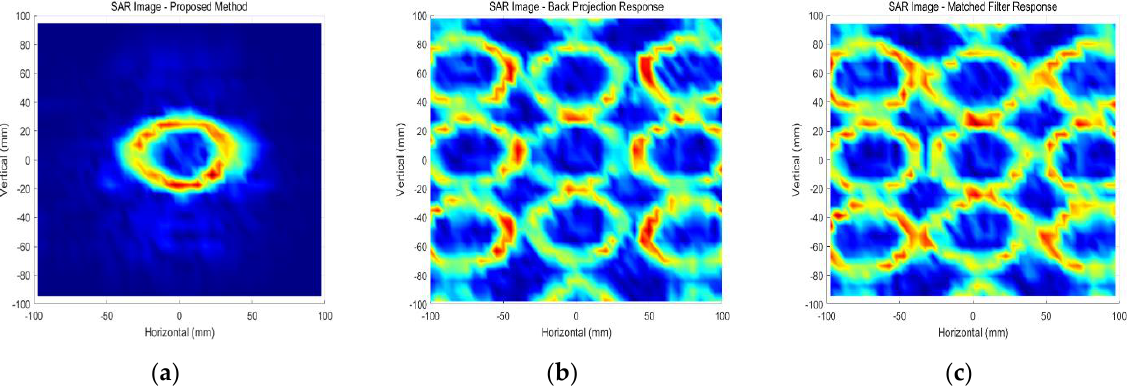
Figure 7. Horizontal direction and vertical direction sparsely-sampled: ( a ) mmSight; ( b ) Back Projection; ( c ) Matched Filter.